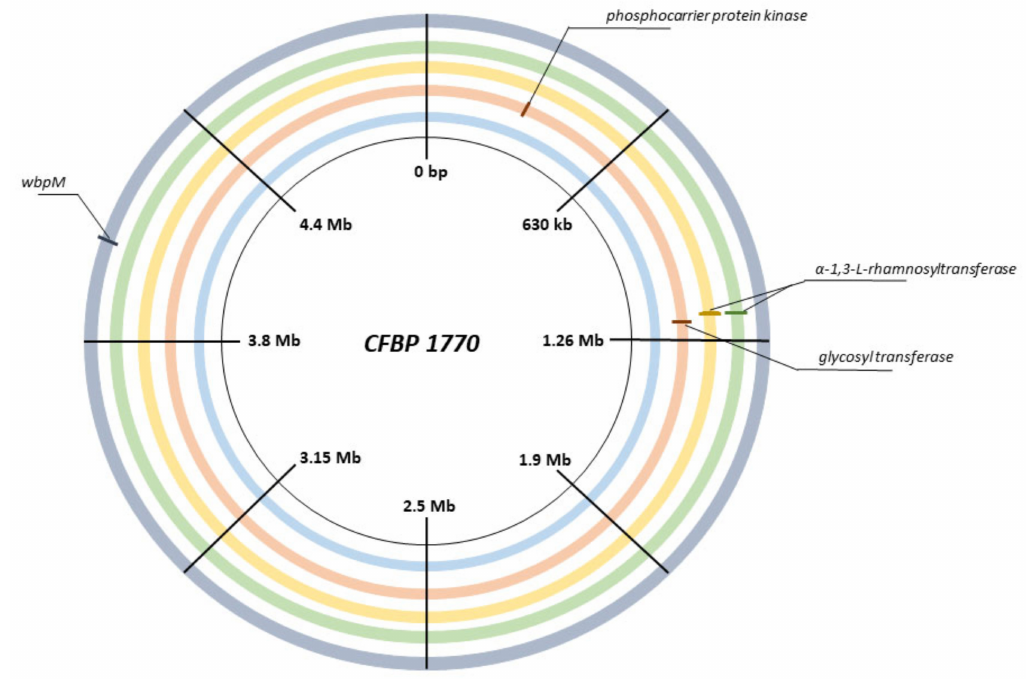
Figure 4. Genomic map of Pseudomonas syringae pv. porri CFBP 1770 and four phage-resistant mutants. The inner ring, in light blue, represents the reference genome. From the outside to the inside, Mutant 1 (grey), Mutant 2 (green), Mutant 3 (yellow), and Mutant 4 (orange) are displayed. The di ff erent SNPs are indicated on the represented genome map. Mutant 1 has a single SNP in wbpM , Mutant 2 and Mutant 3 both have a stop codon in α -1,3-L-rhamnosyltransferase, and Mutant 4 has a SNP in a phosphocarrier protein kinase and a deletion in a Family 2